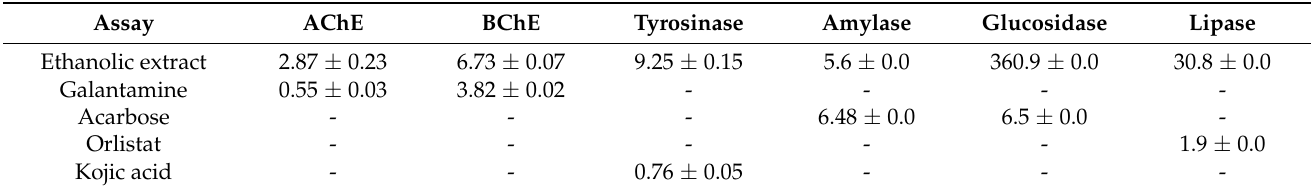
Table 4. Enzymatic inhibitory activity (IC 50 , in µ g/mL) of A. dentata ethanolic extract against AChE,